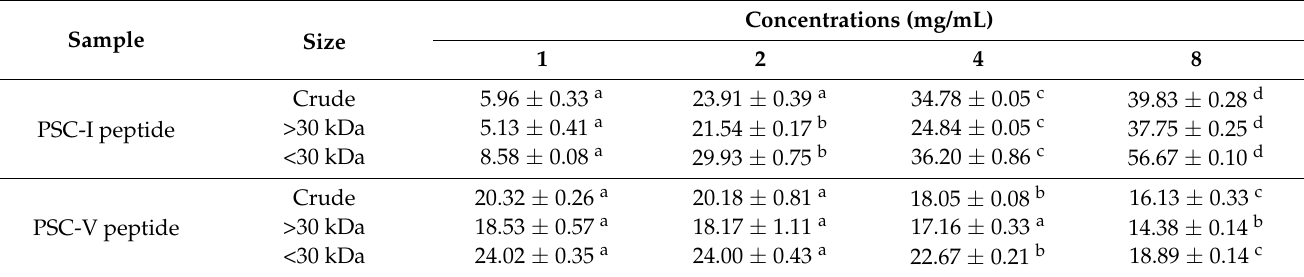
Table 2. HAase-I rates of PSC-I peptide, PSC-V peptide, and ultrafiltered fractions from short- bill spearfish.